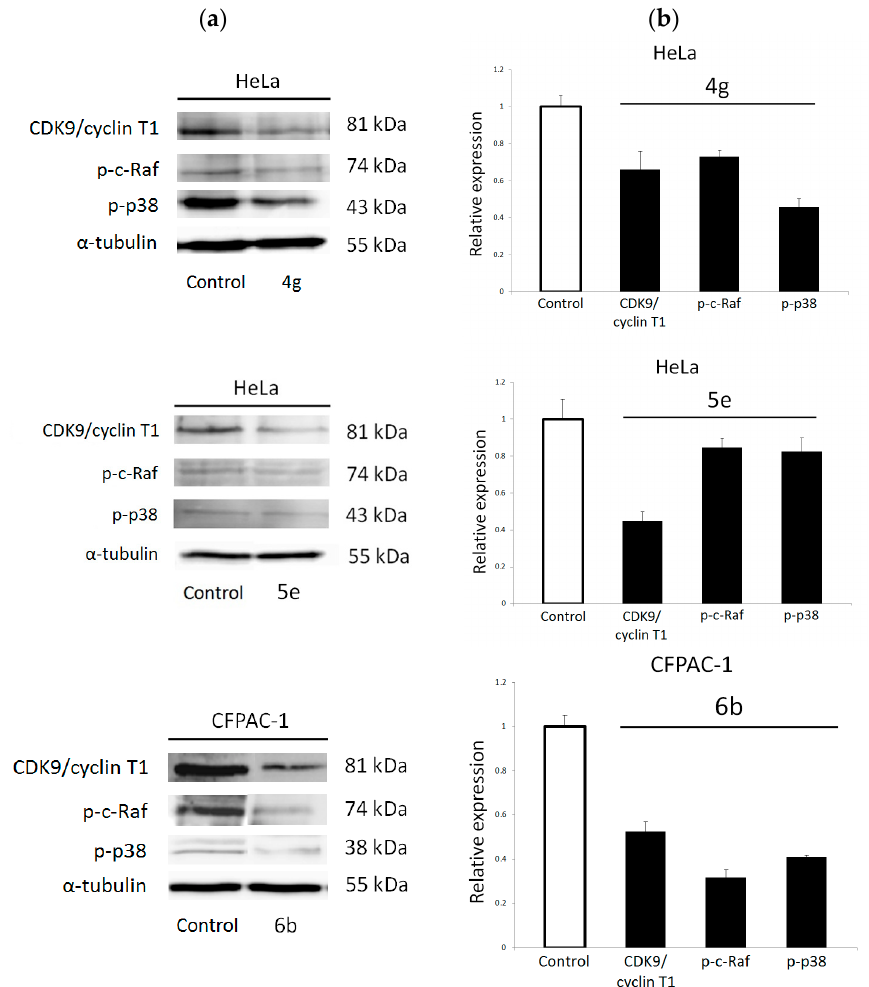
Figure 6. Western blot analysis of predicted protein targets of compounds 4g , 5e and 6b . ( a ) Representative Western blots are shown detecting the cellular levels of selected proteins before and after treatment of the pancreatic adenocarcinoma (CFPAC-1) and HeLa cells with indicated compounds at their 2 × IC 50 values for 48 h. Approximate molecular weights (kDa) are indicated. ( b ) Relative protein expressions, as determined by densitometric analysis of protein bands and normalized to the α -tubulin loading control. Two independent experiments were performed with similar results. Data are presented as mean values ± SD.